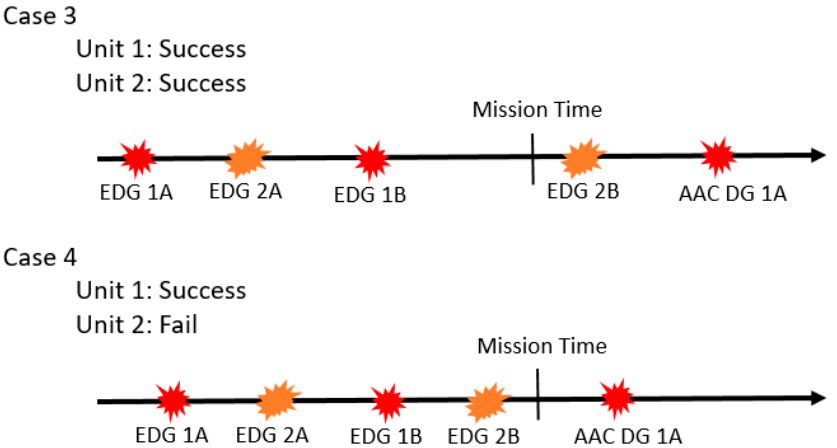
Figure 12. Cutsets for Unit 1 that change to success by considering the order of failures and the status of the power supply for Unit 2.